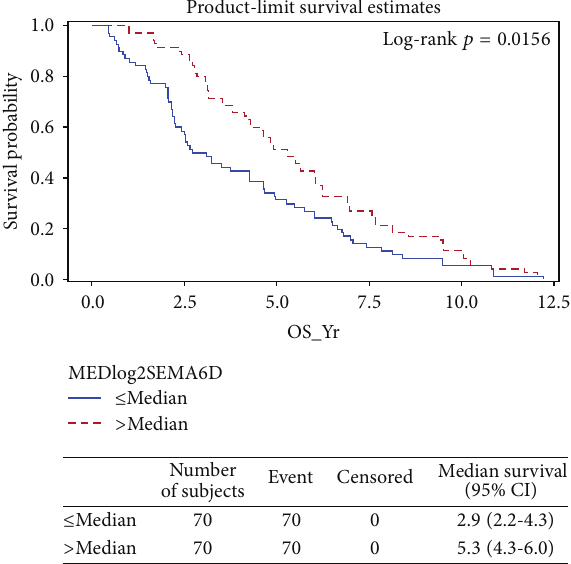
Figure 5: SEMA6D correlates with patient survival.